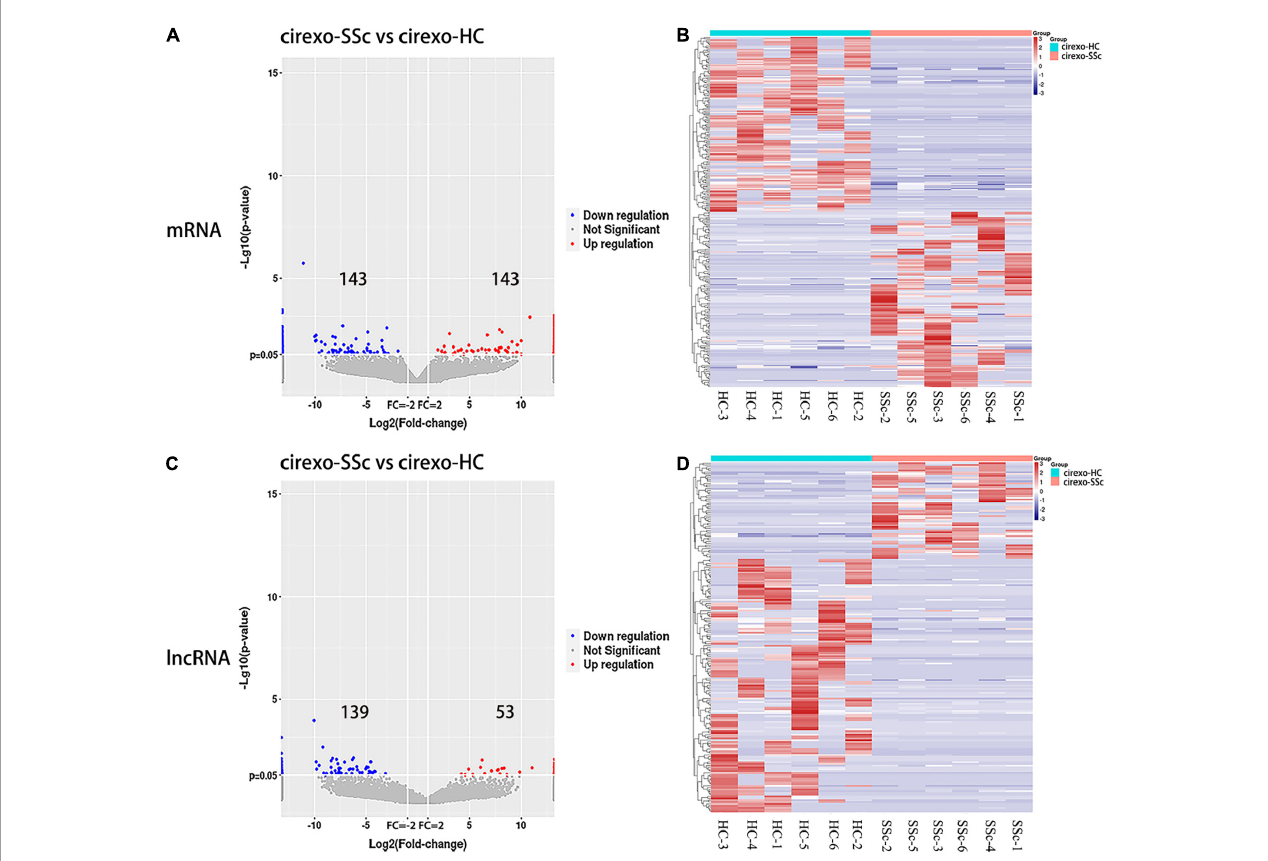
FIGURE3 Expression profiles of mRNA and lncRNA in cirexos in the circulating exosomes–systemic sclerosis (cirexo-SSc) and circulating exosomes–healthy control (cirexo-HC) groups ( n = 6). (A,C) Volcano plots show upregulated (red) and downregulated (blue) mRNA and lncRNA. The abscissa represents the fold change of gene expression in the different samples [log2 (fold-change)], and the ordinate represents the significance level of the differential gene expression [–log10 ( p -value)]. (B,D) Heatmaps showing the hierarchical clustering analysis of differentially expressed mRNAs (DEmRNAs) and differentially expressed lncRNAs (DElncRNAs). The rows represent genes, and the columns represent the expression of the same sample. Red indicates high expression, and blue indicates low expression.